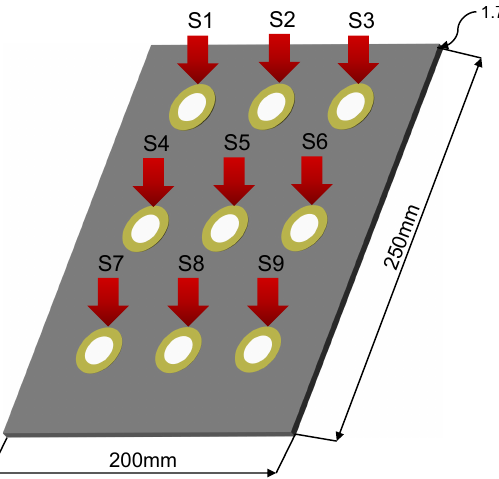
Figure 29. Graphic representation of the third specimen